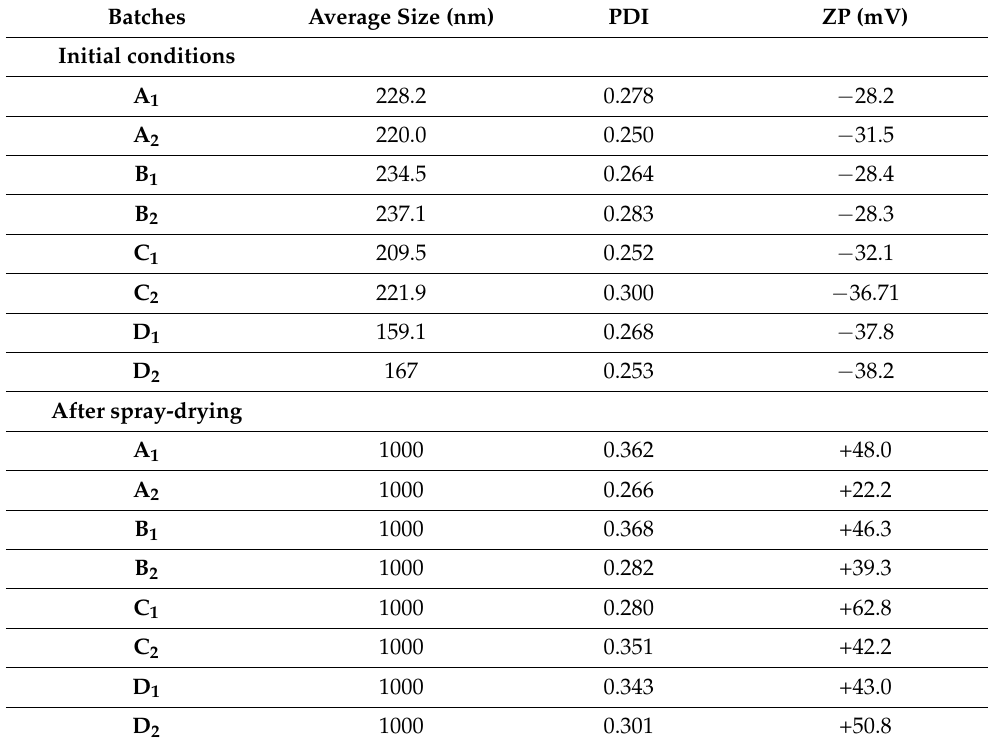
Table 2. Technological parameters of the pre-spray-dried and post-spray-dried samples.